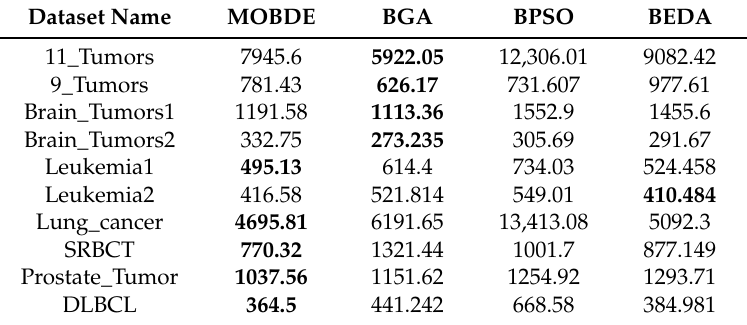
Table 9. Comparative experimental times of the differential evolution algorithm with different multiobjective optimization